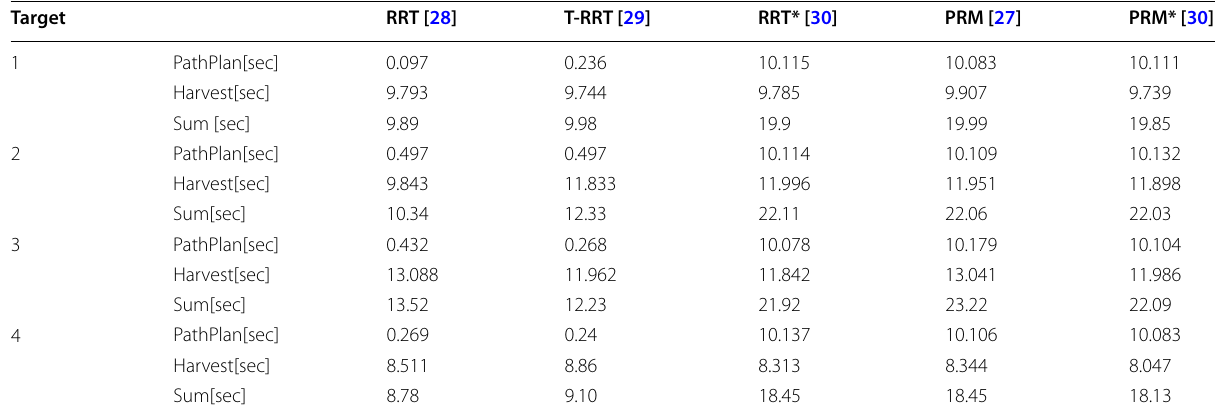
Table 3 Comparison of path planning methods Target